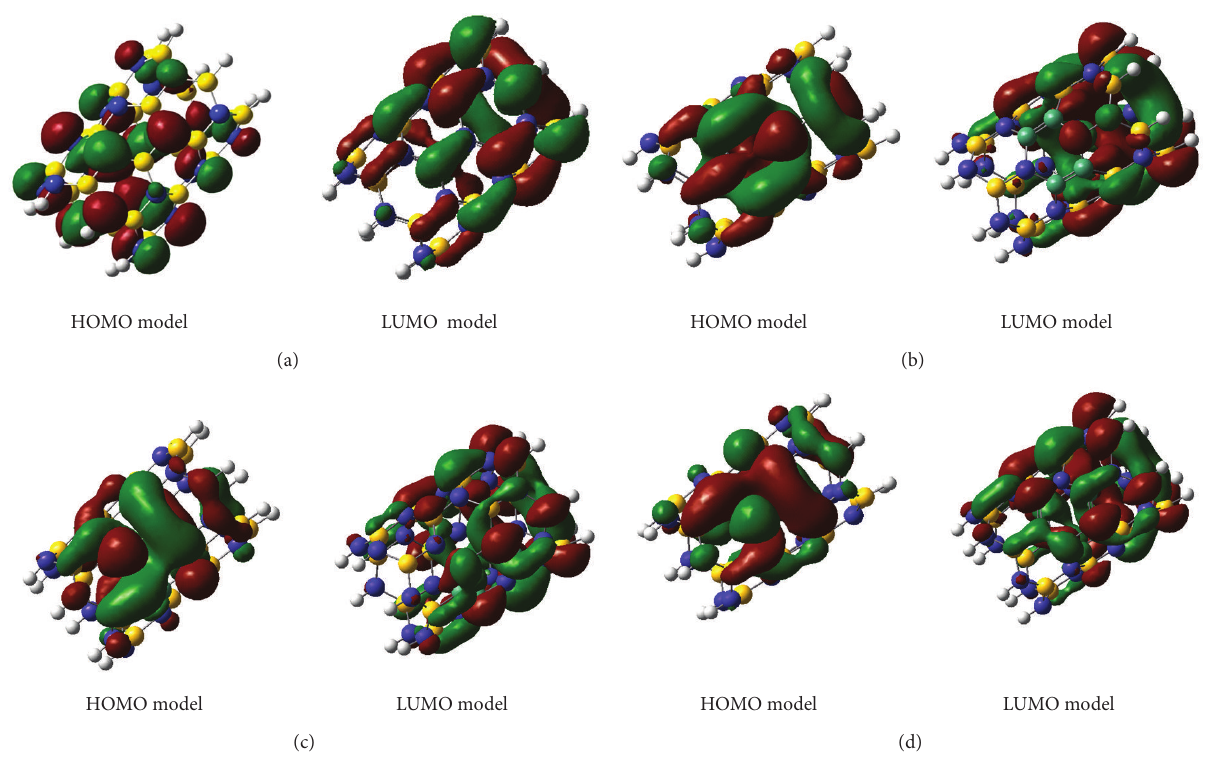
F 3: HOMO and LUMO orbitals for different models of the BNNTs: (a) perfect model, (b), (c), and (d) pyrazine-doped models.